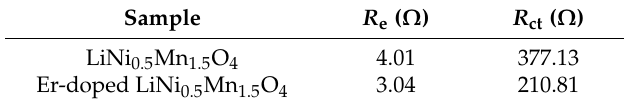
Table 1. Impedance fitted data from EIS spectra for the LiNi 0.5 Mn 1.5 O 4 and Er-doped LiNi 0.5 Mn 1.5 O 4